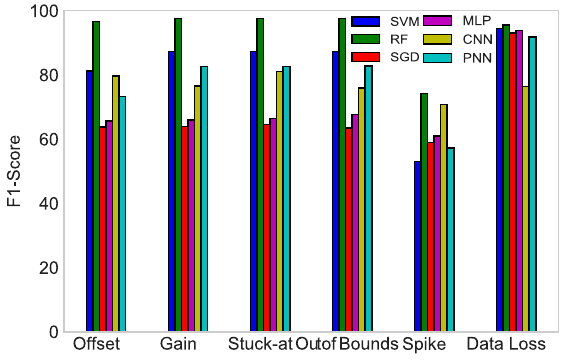
Figure 12. F1-score of SVM, RF, SGD, MLP, CNN, and